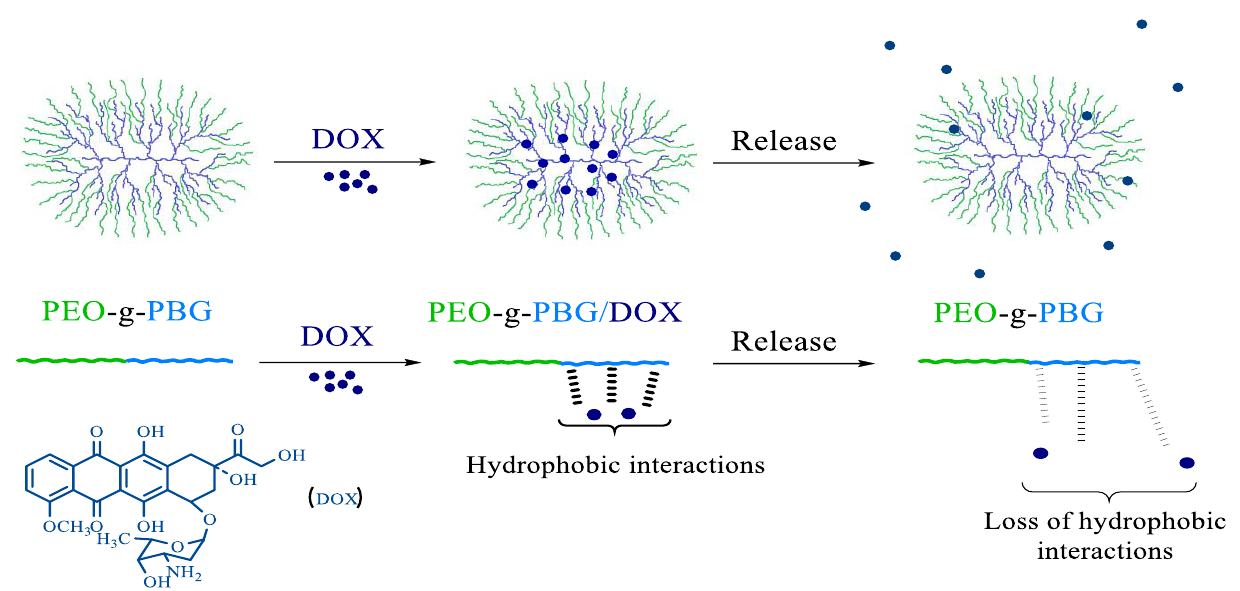
Scheme 3. Schematic representation of the encapsulation and release of DOX in the PBG core of G2PBG- g -PEO through hydrophobic interactions.